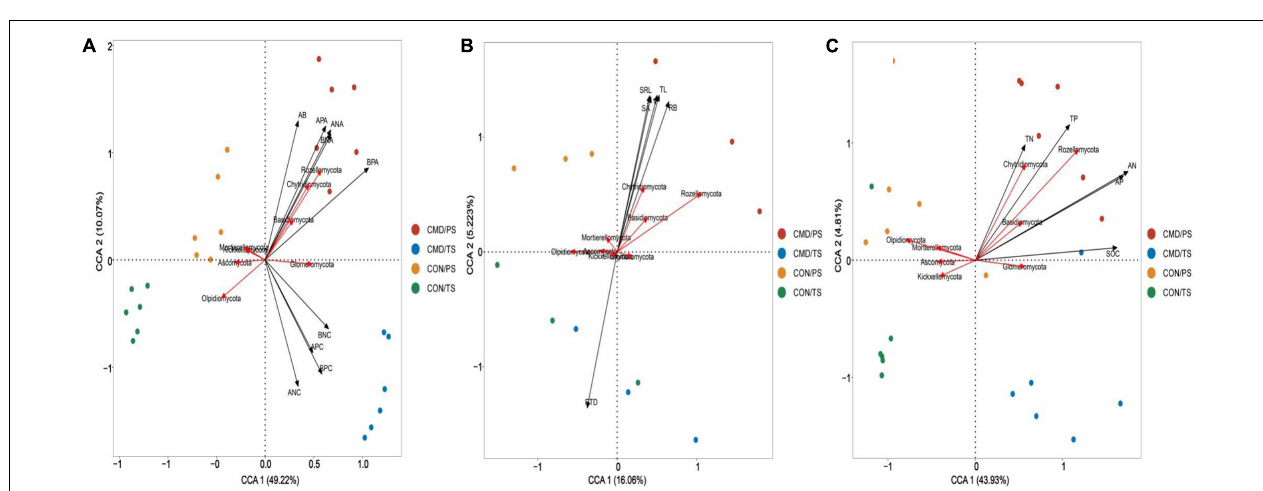
FIGURE 8 | Canonical correspondence analysis (CCA) showing fungal community composition at phyla level as affected by biomass and nutrient absorption and return (A) , and root traits (B) soil chemical property (C) . Microbial community composition located in the forward direction of the arrow of the environmental factor implies positive relationship between the microbial community composition and the environmental factor, and vice versa. CON, control; CMD, cattle manure